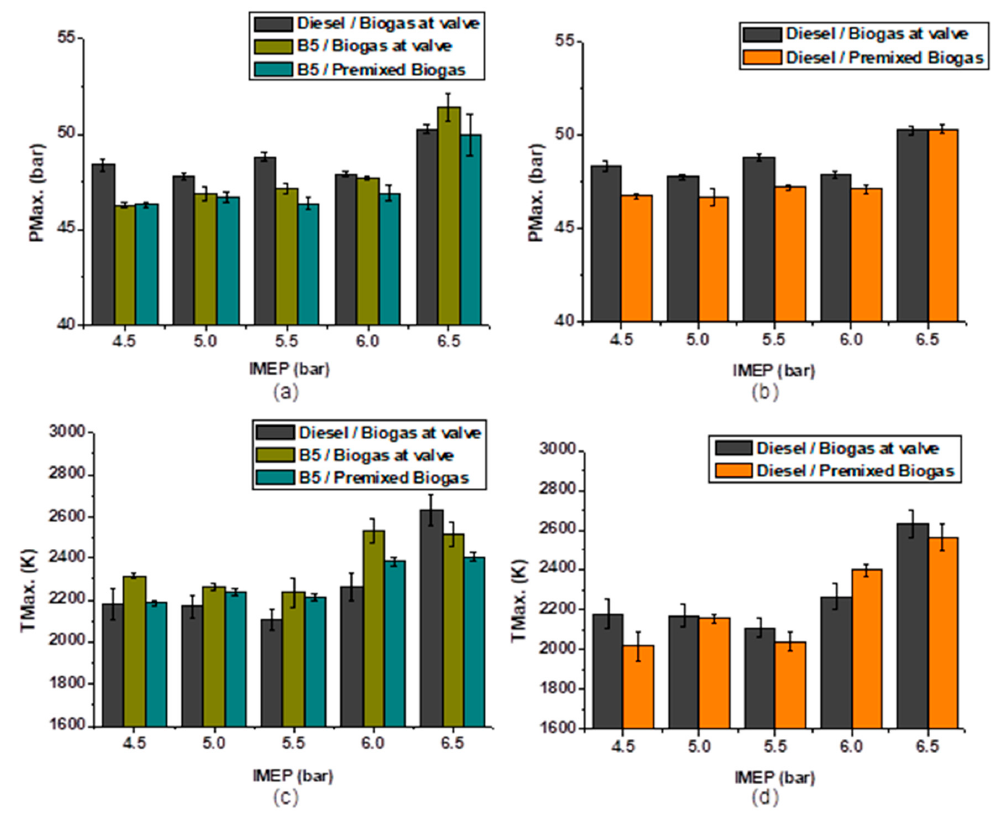
Figure 6. Variation of ( a ) maximum in-cylinder pressure (PMax.) for B5 / biogas RCCI combustion, ( b ) maximum in-cylinder pressure for biogas injection approaches in RCCI, ( c ) maximum in-cylinder temperature (TMax.) for B5 / biogas RCCI combustion, and ( d ) maximum in-cylinder temperature for biogas injection approaches in RCCI.